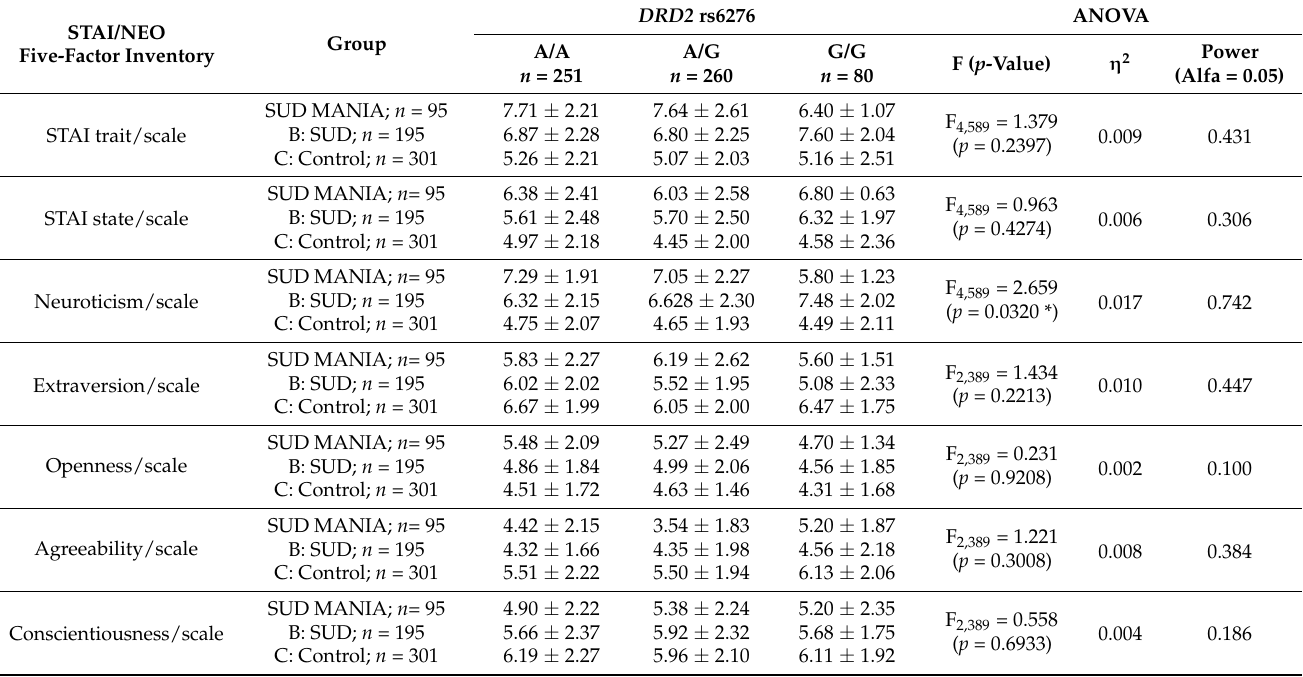
Table 5. Differences in DRD2 rs6276 and NEO Five-Factor Inventory, STAI scale between healthy control subjects and SUD and SUD MANIA.